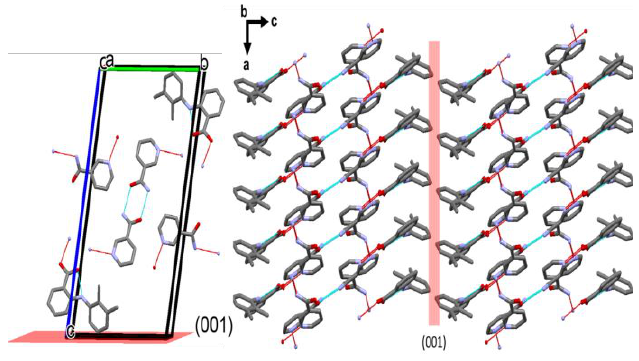
Fig. 6. The crystal packing and flat shape of MFA-NIC slip plane (red